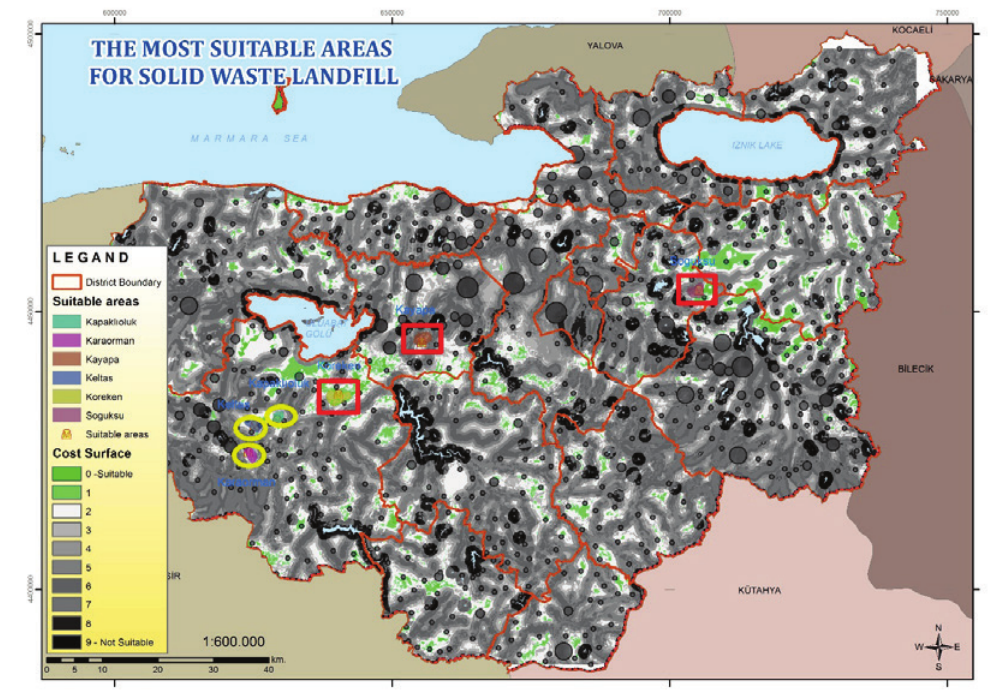
Figure 6. The most suitable solid waste landfill areas Table 2. Statistical evaluation of alternative solid waste landfill areas Raster GIS-based Evaluation factor